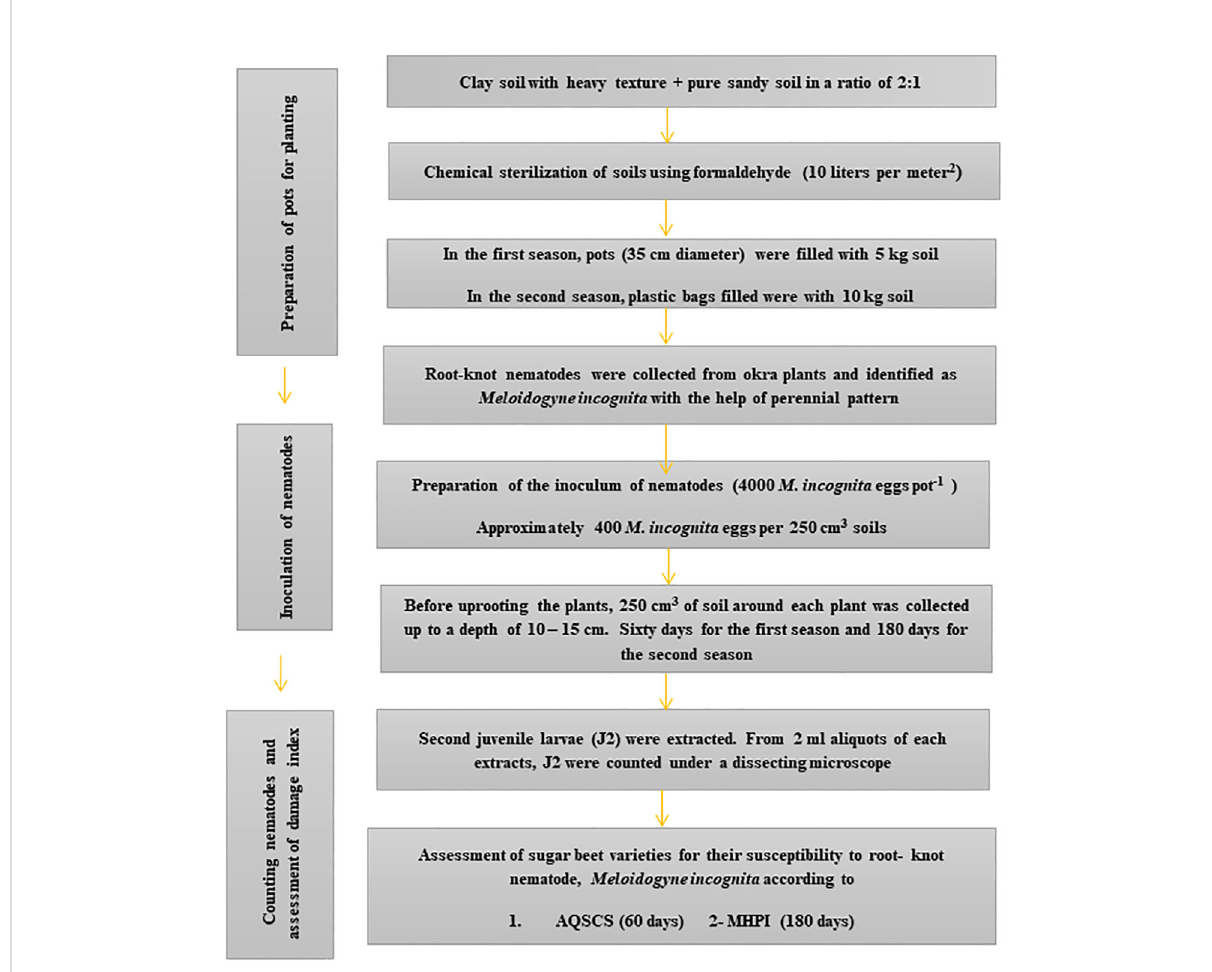
FIGURE 1 Steps of the outdoor pots experiment for sugar beet (Beta vulgaris saccharifera) genotypes suitability towards root-knot nematode, Meloidogyne incognita by two quantitative and qualitative schemes. AQSCS, adaptive quantitative scheme of Canto-Saenz ’ s; MHPI, modi fi ed host-parasite